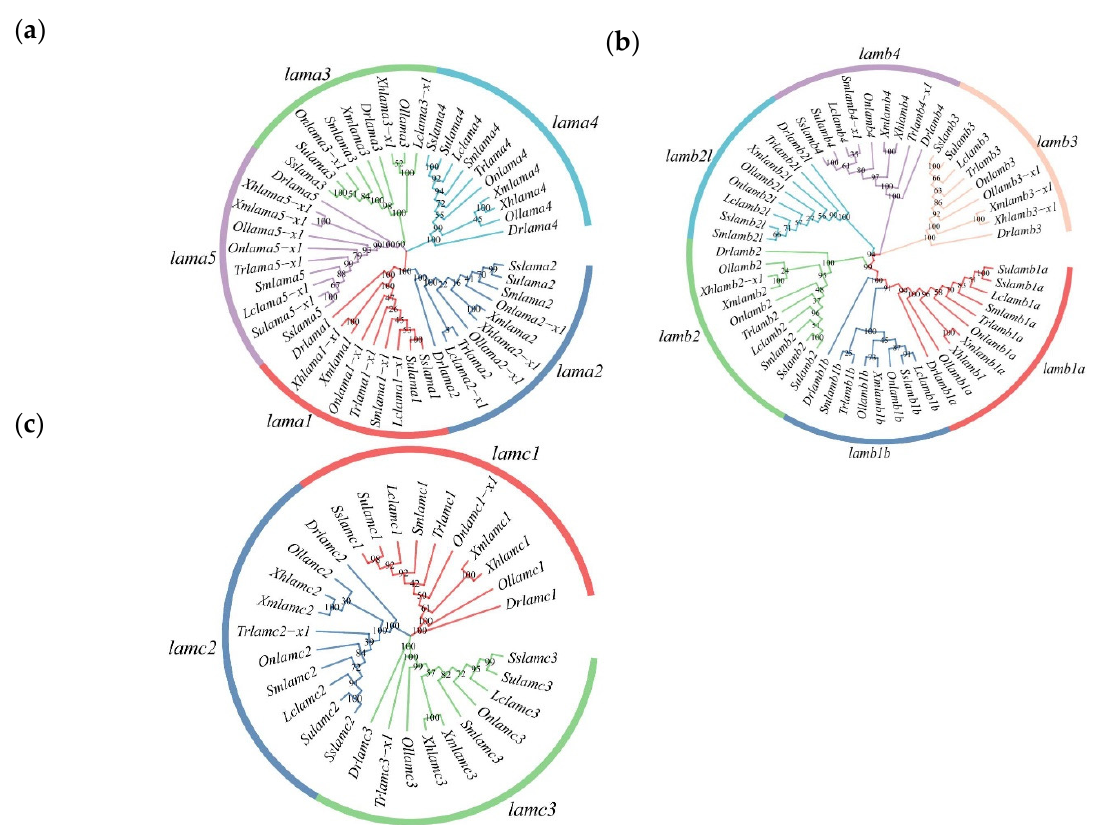
Figure 1. Phylogenetic analysis of laminin nucleotide sequence of ten species. Dr ( Danio rerio ), Lc ( Larimichthys crocea ), Sm ( Scophthalmus maximus ), Ol ( Oryzias latipes ), Tr ( Takifugu rubripes ), On ( Oreochromis niloticus ), Xm ( Xiphophorus maculatus ), Xh ( Xiphophorus helleri ), Ss ( S. schlegelii ) and Su ( S. umbrosus ). The numbers on the graph represent approval ratings. ( a ) Phylogenetic tree of laminin α chains; ( b ) Phylogenetic tree of laminin β chains; ( c ) Phylogenetic tree of laminin γ chains. The same gene from different species comes together to form a single branch with the same color.